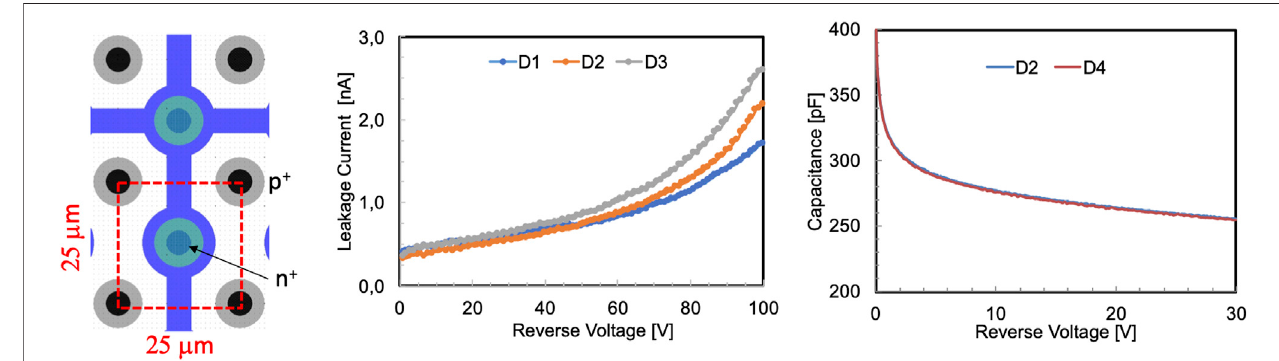
FIGURE3| Layoutdetail(left),I-Vcurves(center),andC-Vcurves(right)of3Ddiodeswith25 μ m×25 μ mbasiccell.Differentdevicesamplesfromthesamewafer (D1, D2, D3, and D4) are indicated in the